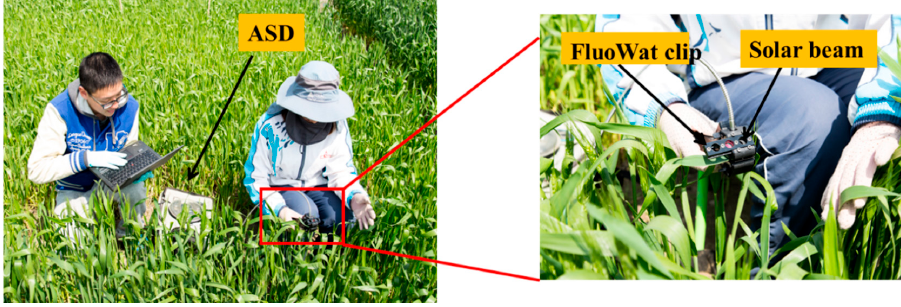
Figure 2. Drawing of the SIF measurement.